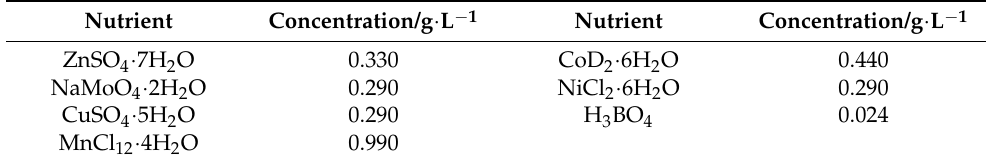
Table 1. The nutrient solution composition.